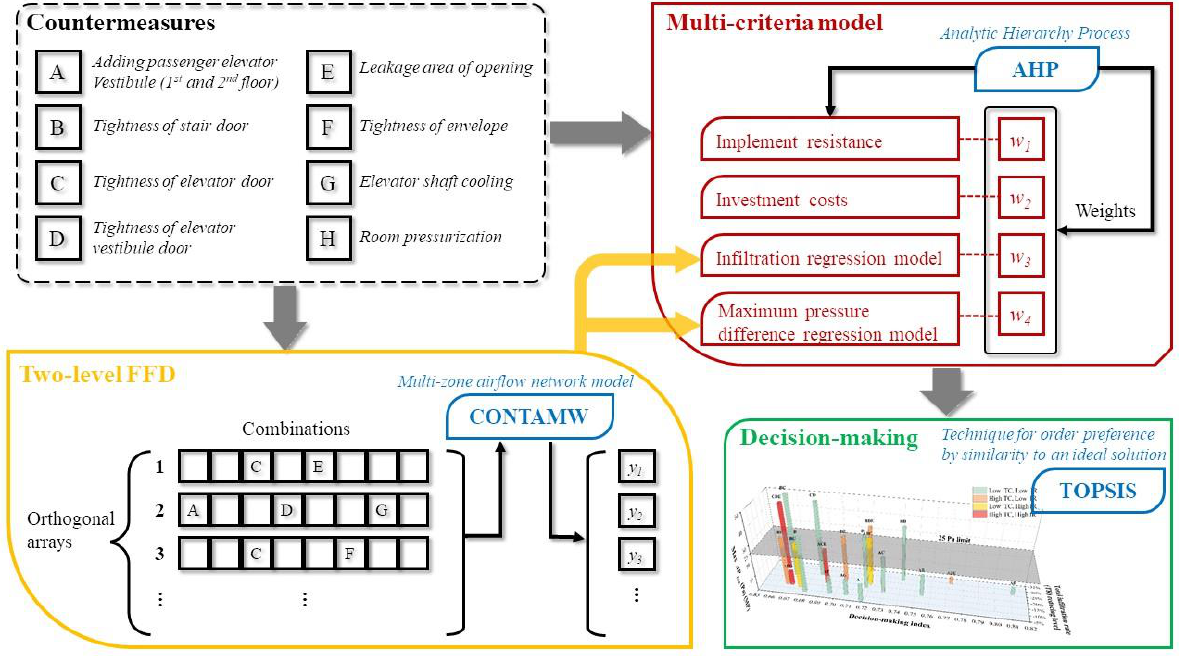
Figure 5. Research